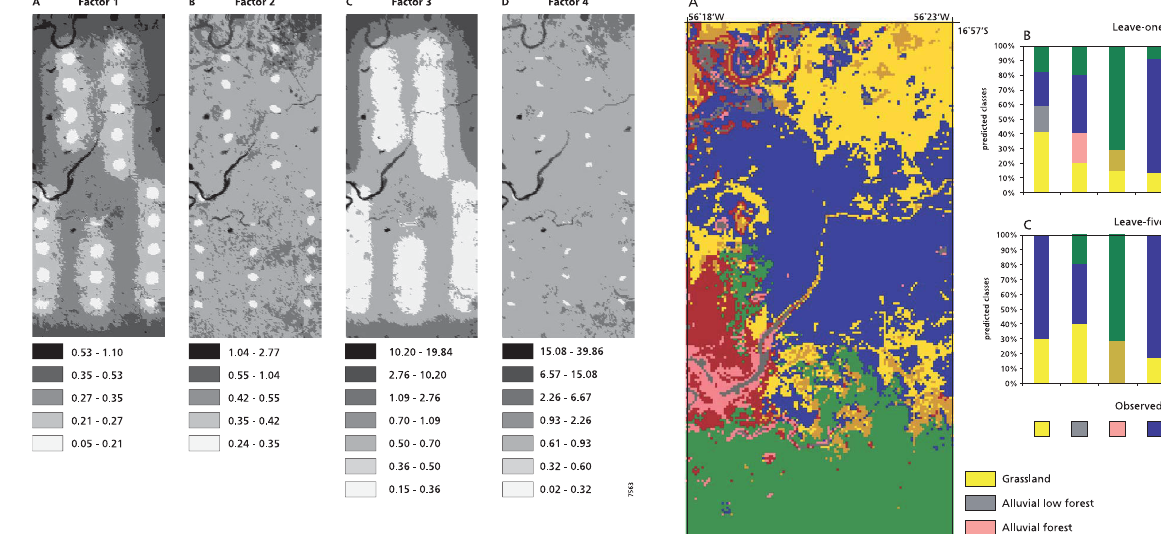
Fig. 6. Maps of the standard deviation of the predicted error result- ing from universal kriging; (A) Factor 1; (B) Factor 2; (C) Factor 3; (D) Factor 4.